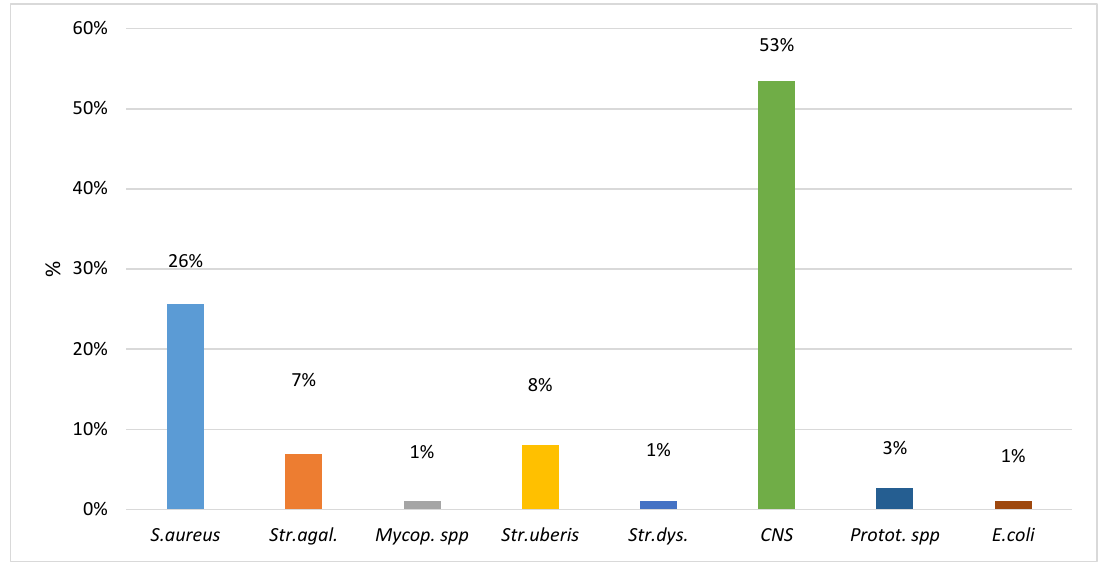
Figure 1. Proportion of bacteria species recovered in 187 qPCR positive milk samples with ≤50,000 cells/mL.